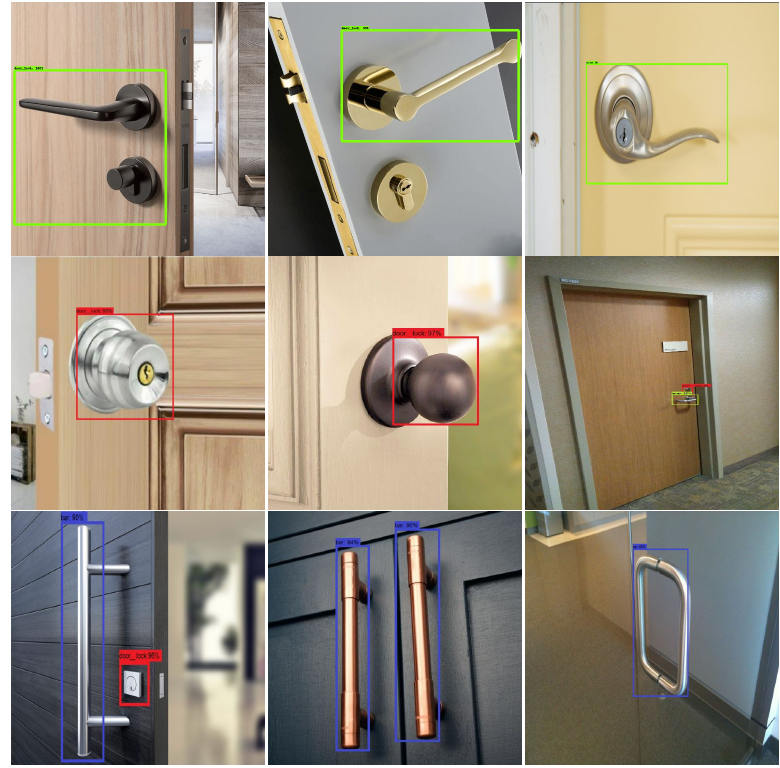
Figure 6. offline test results Figure 6. Offline test